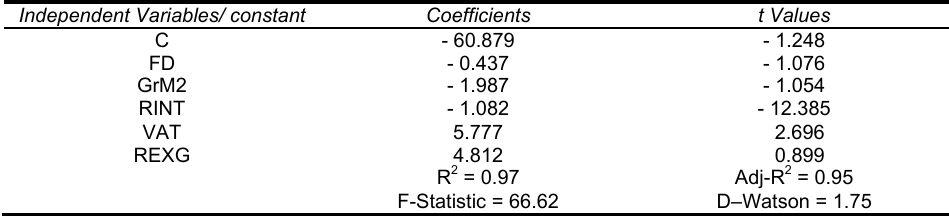
Table 2: Determinants of inflation (INF) Independent Variables/